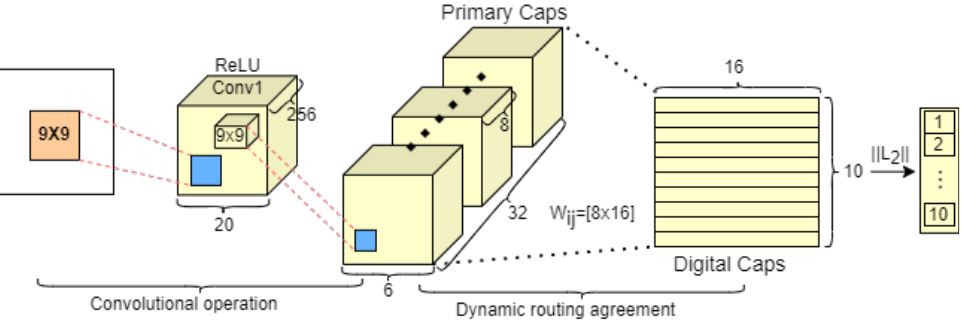
Figure 4. The basic architecture of Capsnet.